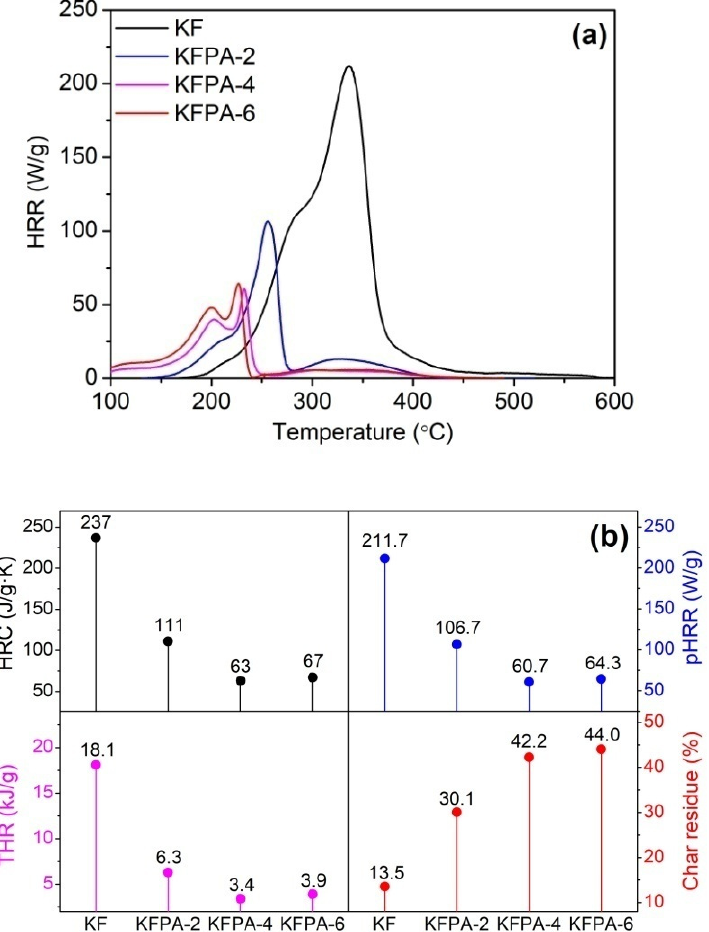
Figure 8. Heat release rate (HRR) curves ( a ) and PCFC parameters ( b ) of KF and phosphorylated KF samples prepared at various PA dosages (PA 2, 4, and 6 g, 150 °C, and 90 min).